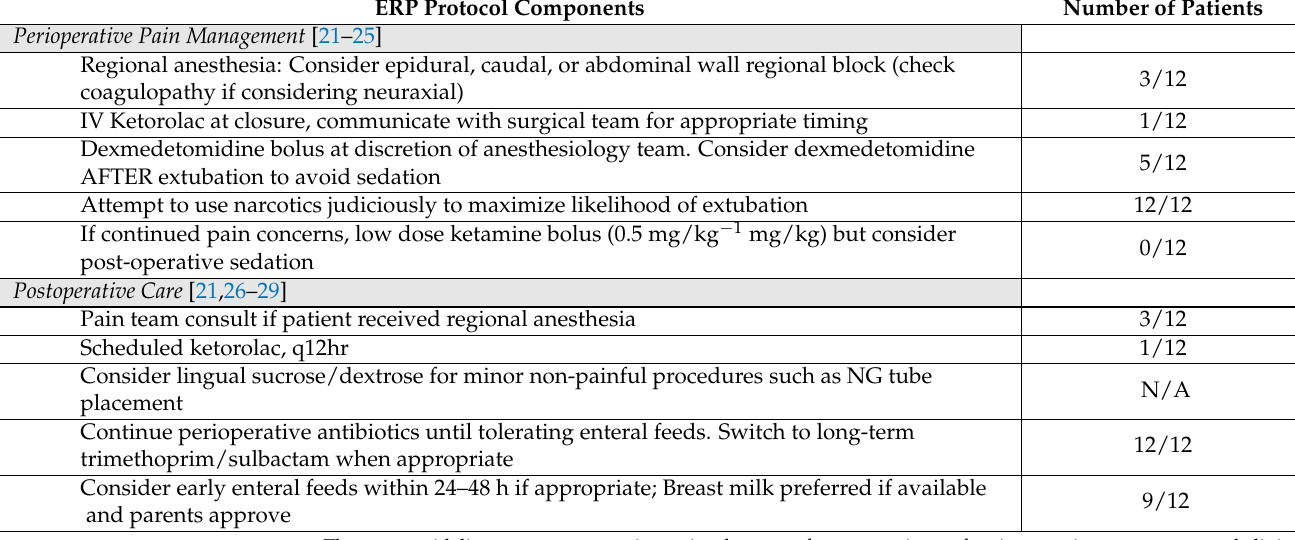
Table 1. Cont. ERP Protocol Components Number of